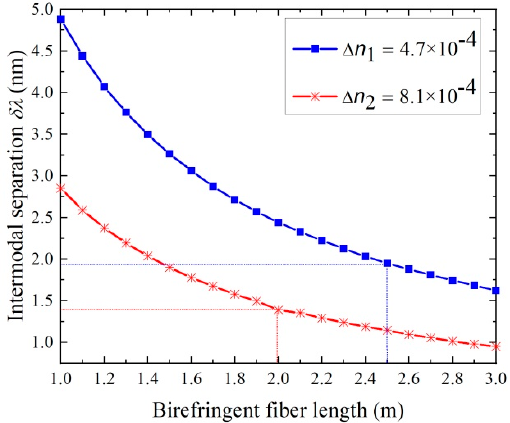
Figure 2. Variation of the intermodal separation as a function of the fiber length [9].